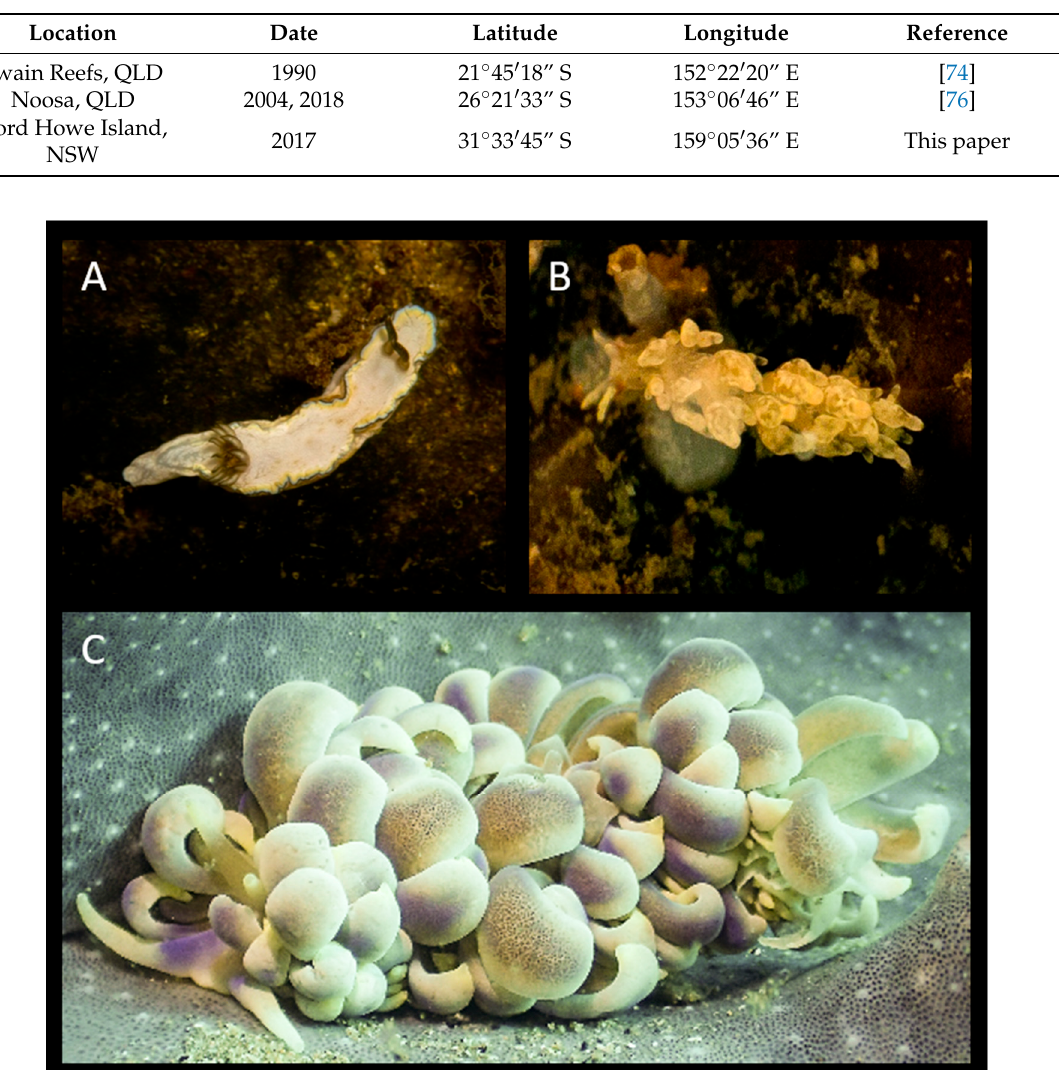
Figure 3. ( A ) Doriprismatica paladentata Cook Island, NSW, 24 September 2017. Photo: S. Hofmann. ( B ) Phestilla minor , Nelson Bay, NSW, 9 September 2017. Photo: P. Davey. ( C ) Phyllodesmium magnum